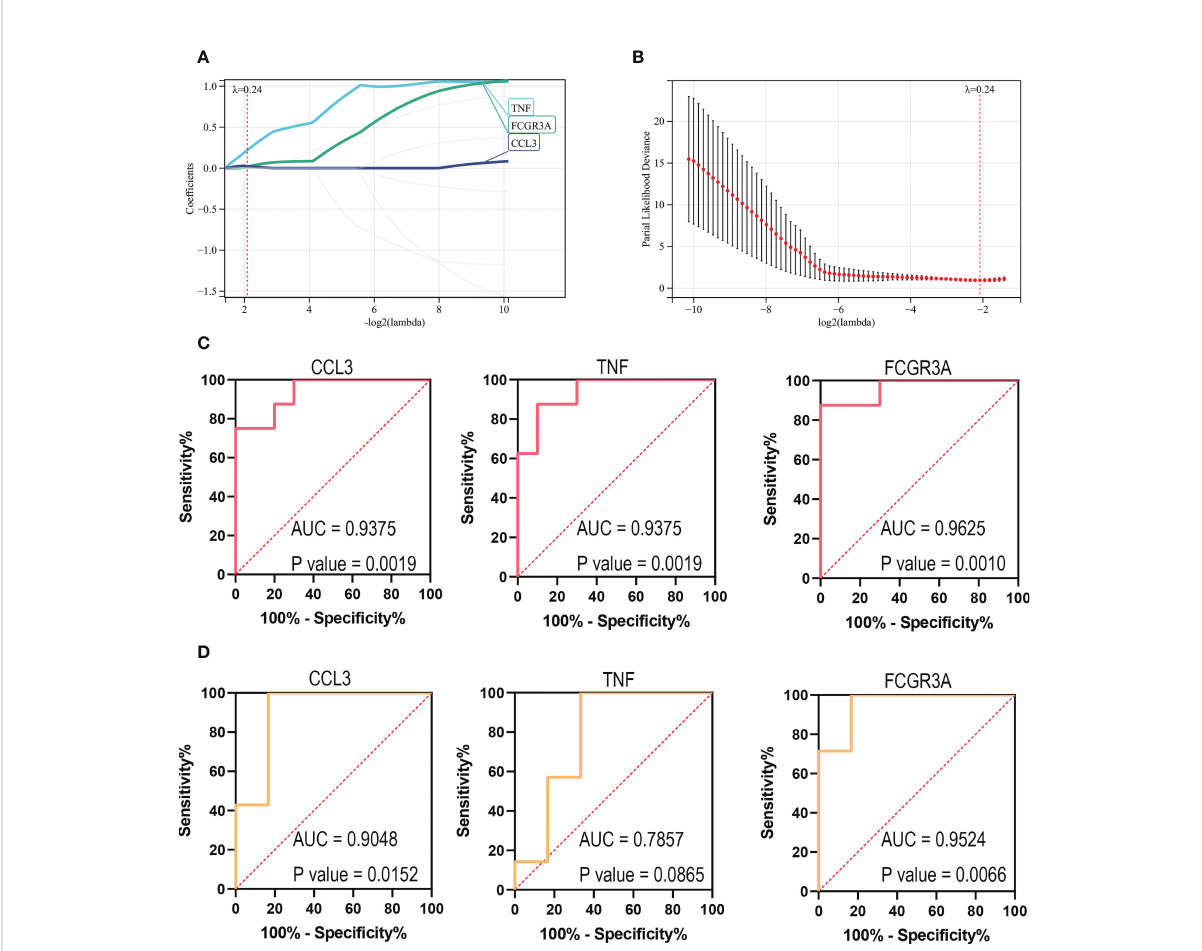
FIGURE 7 Identi fi cation of the key genes. (A, B) Further screening of hub genes by machine learning LASSO regression, CCL3, TNF, and FCGR3A, were identi fi ed as key genes. (C) ROC curves of CCL3, TNF, and FCGR3A in the training set (GSE72540). (D) ROC curves of CCL3, TNF, and FCGR3A in the veri fi cation set